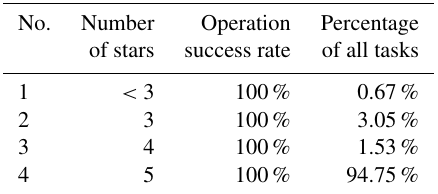
Table 12. Statistics of AGRI star selection tasks. Table 13. Statistics of GIIRS star selection